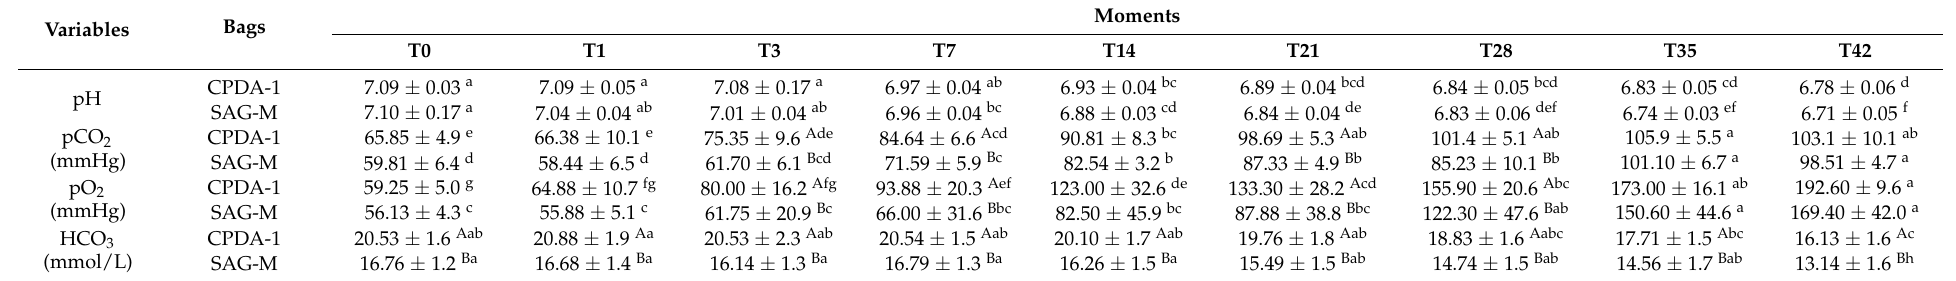
Table 2. Mean and standard deviation values of blood gas variables of donkey whole blood stored in CPDA-1 and CPD/SAG-M bags for 42 days.